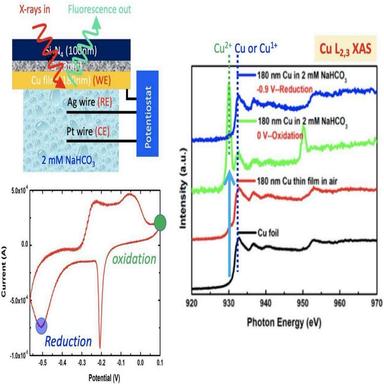
Left upper: illustration of electrochemical cell; Left bottom: Cu redox curve in 0.002 M Na2CO3 water solution; Right: XAS spectra of Cu electrode under oxidation/reduction condition. Reference metallic Cu foil together with the Cu thin film (~300 nm) evaporated on the Si3N4 membrane (oxidized during transfer in air). Spectra (3) and (4) were recorded after in-situ oxidation at nominally 0.2 V and after reduction at nominally 0.9 V in 2 mM NaHCO3 solution, respectively.